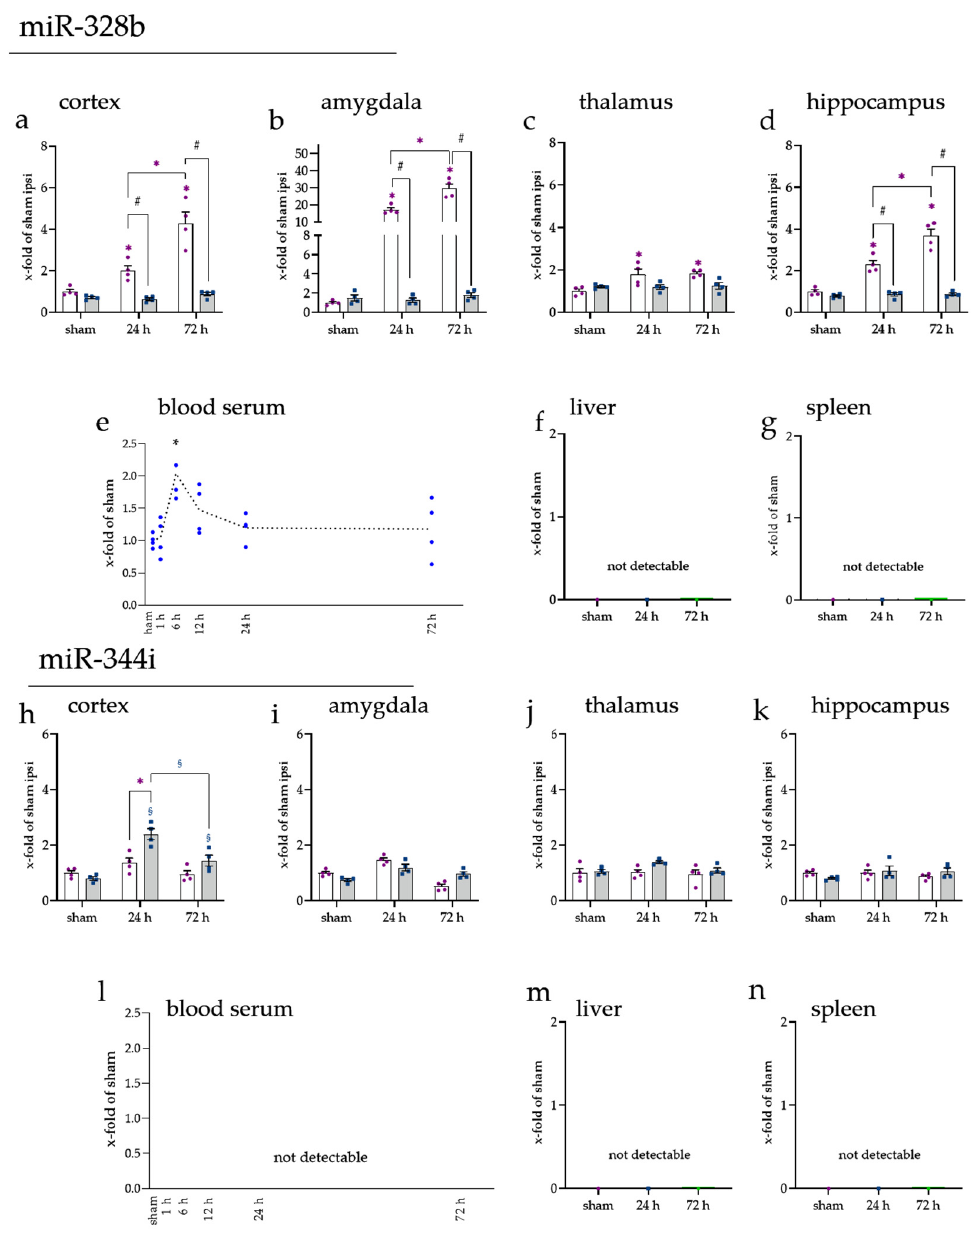
Figure A5. Expression of brain-enriched miRNAs miR-328b-3p ( a – d ) and miR-344i ( h – k ) in the investigated peri-infarct area and non-affected brain regions, ( e ) blood serum, ( f ) liver, and ( g ) spleen. In the brain, miR-328b was dysregulated in different brain regions and showed a short boost in the blood serum. Note that miR-328b-3p was not detectable in the spleen and liver. On the contrary, miR-344i showed only a slight increase in the peri-infarct area in the cortex but was not detectable neither in the blood serum ( l ) nor in the peripheral organ’s spleen ( n ) and liver ( m ). (*) shows a significant difference between the ipsilateral side and sham ipsi, where (§) shows a significant difference between the contralateral side and sham contra. (#) comparison as